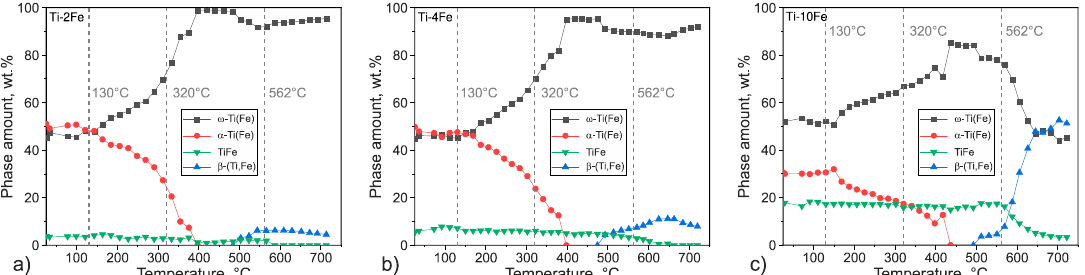
Figure 7. Temperature dependences of the phase composition in alloys Ti-2Fe ( a ), Ti-4Fe ( b ), and Ti-10Fe ( c ) obtained from the HTXRD measurements carried out upon heating. The integral intensities were normalized to the phase compositions at the initial state of samples after HPT (Table 2). The intensities of the diffraction lines 1010, 0002, and 1011 of α -Ti and α -Ti(Fe), and 1011 and 1120 of ω -Ti(Fe) were summed up. The temperature axes of the HTXRD measurements were calibrated according to the DSC measurements.